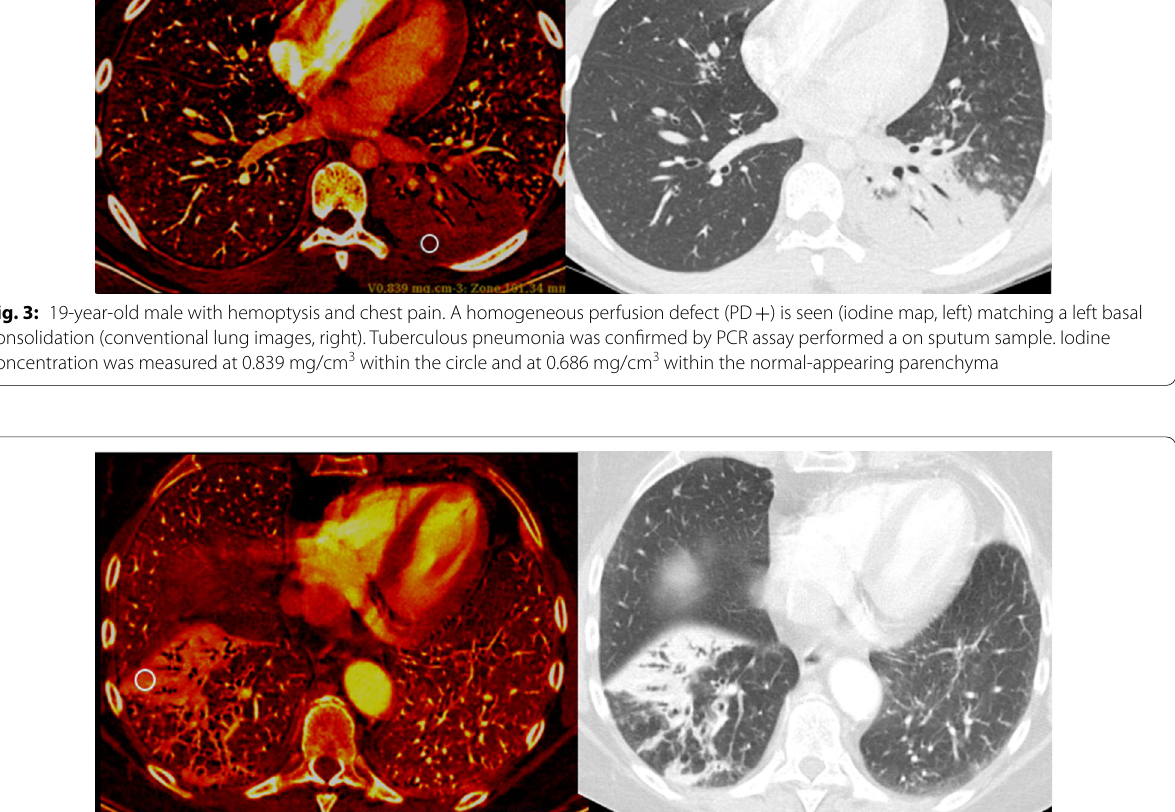
Fig. 4: 75‑year‑old female with bronchopneumonia and suspected PE. No perfusion defect was detected (PD‑). Instead, a homogeneous high iodine distribution is seen (iodine map, left) matching consolidations in the right anterior basal segment (conventional lung images, right). The patient was treated with Ceftriaxone with a favorable outcome. Iodine concentration was measured at 6.053 mg/cm 3 within the circle and at 0.723 mg/cm 3 within the normal‑appearing